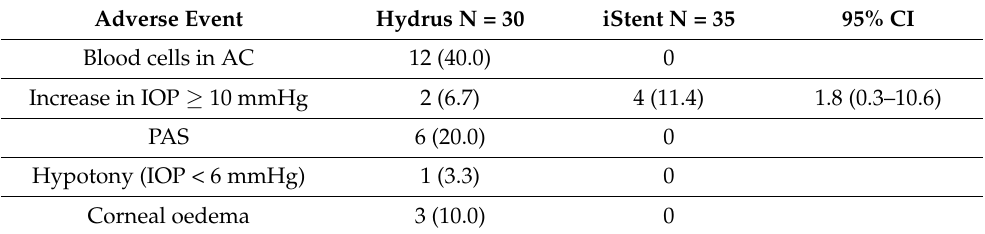
Table 4. List of postoperative